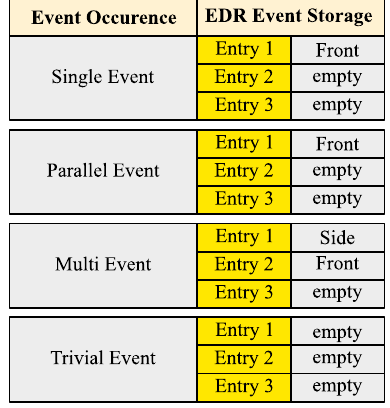
Figure 6. Event occurrence and storage.